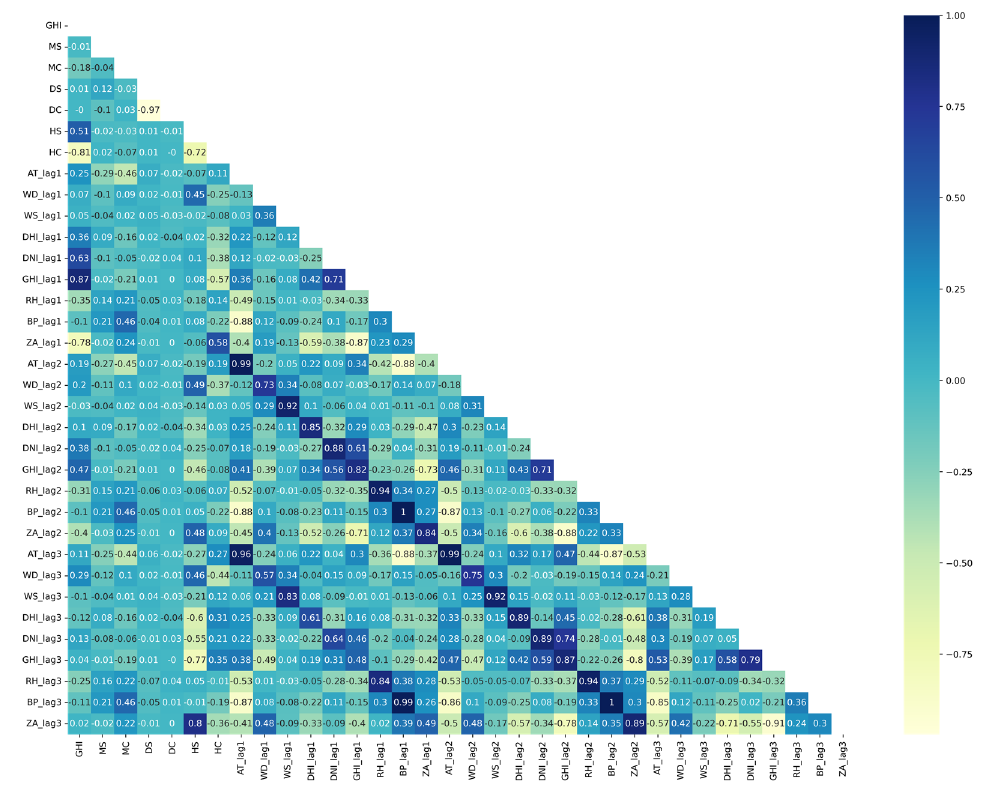
Figure 11. Al-Jouf dataset correlation matrix.